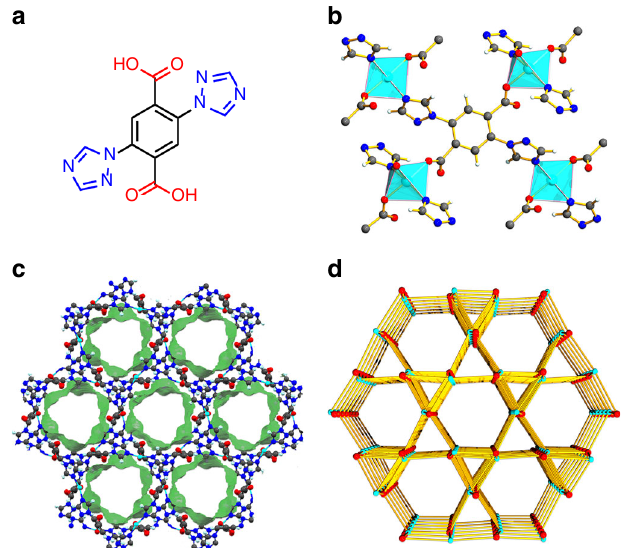
Fig. 1 Structural illustration of FJI-H14. a The selected ligand H 2 BTTA for the construction of FJI-H14 . b The coordination environment of the Cu(II) ions as four-connected nodes and BTTA also as a four-connected node. c The one-dimensional nanoporous channels along the crystallographic c direction. d The framework of USF topology. (Cu atom, cyan; C atom, gray; O atom, red; N atom, blue; H atom,